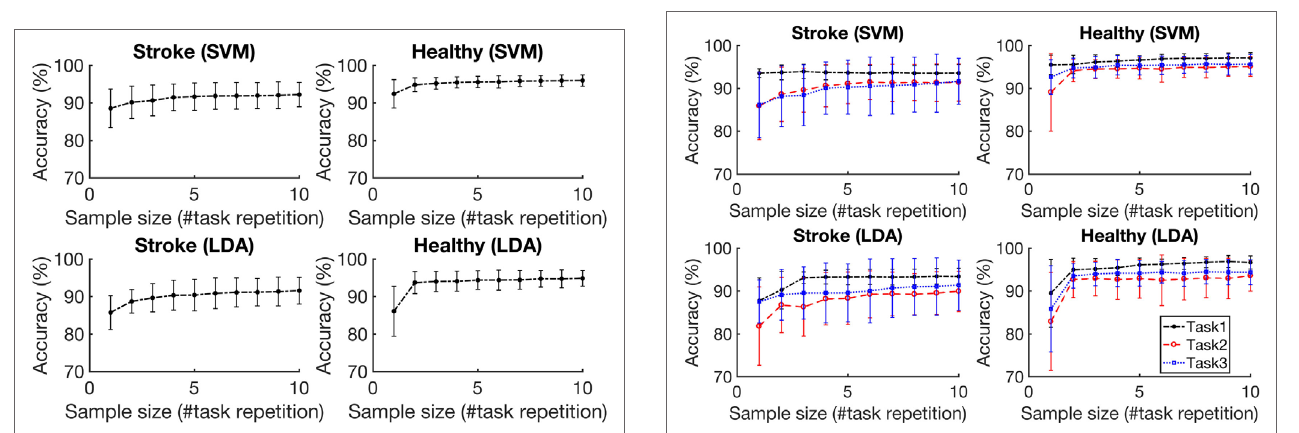
FigUre 6 | Classification accuracy vs. training set size for each task. Task 1, Task 2, and Task 3 are the grasp and move tasks in the lateral, upward, and forward directions, respectively. The accuracies were averaged across eight subjects for each population. The error bars represent 1 SD.